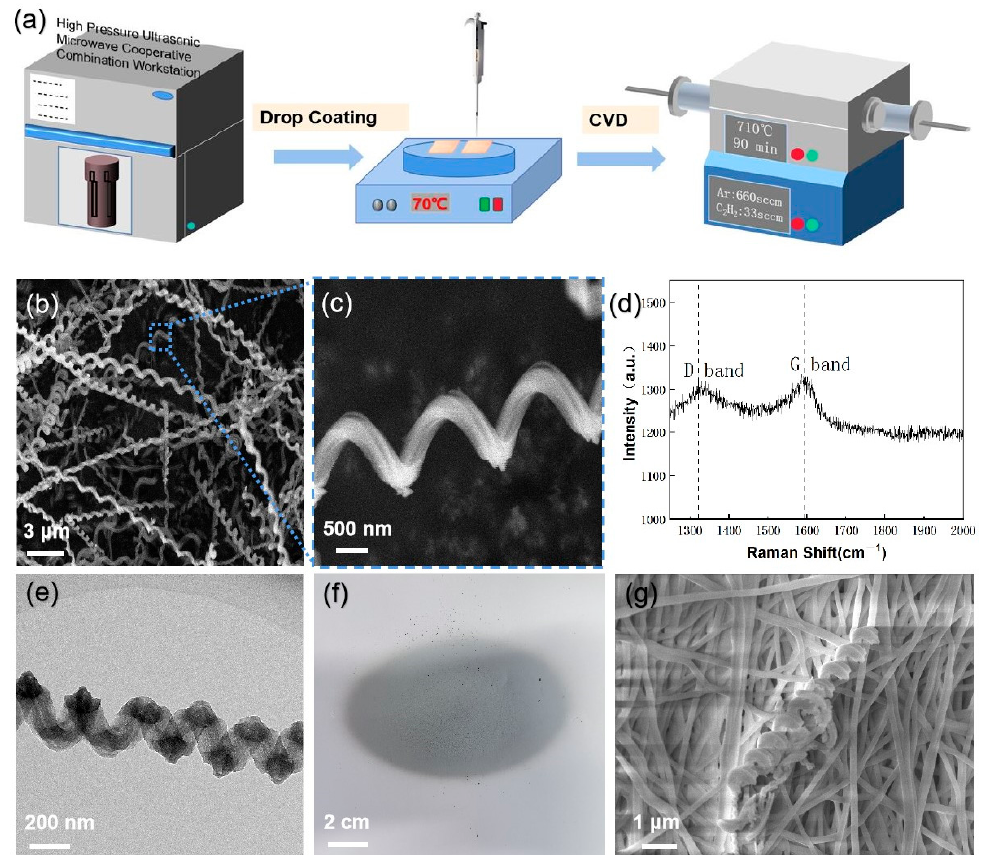
Figure 4. ( a ) Flow chart of CNCs preparation using the microwave heating method and CVD; ( b ) SEM image of CNCs; ( c ) SEM enlarged image of the partial CNC; ( d ) Raman shift of the CNCs; ( e ) TEM image of the partial CNC; ( f ) optical photograph of the fabricated composite film; and ( g ) SEM image of the fabricated film with CNCs.